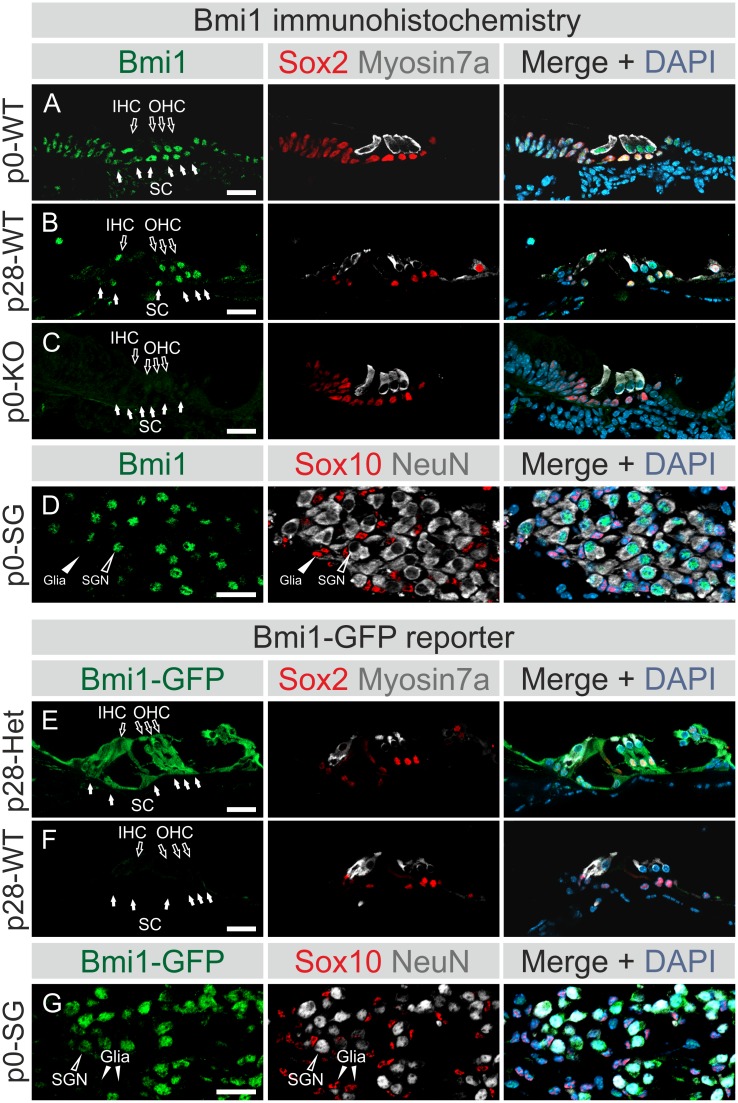
Bmi1 expression in the cochlear sensory epithelium.(A, B, and D) Immunohistochemical staining was performed using an anti-Bmi1 antibody on wildtype mice (Bmi1WT/WT, referred to as WT). (E and G) Alternatively, immunolabeling was performed using an anti-GFP antibody on Bmi1-GFP heterozygous mice (Bmi1GFP/WT, referred to as Het). OC sections (A-C, E and F) were co-stained for Sox2 (red) and Myosin7a (white) as markers of supporting cells and hair cells, respectively. Hair cells are marked by hollow white arrows, and supporting cells are indicated by solid white arrows. Spiral ganglion sections (D and G) were co-labeled with Sox10 (red) and NeuN (white) to serve as markers of glial and neuronal cells, respectively. Spiral ganglion neurons are labeled with hollow white arrowheads, and glial cells are marked with solid white arrowheads. (A) Bmi1 is expressed in the immature OC at p0. Both hair cells and supporting cells were labeled for Bmi1. (B) Bmi1 expression was detected in hair and supporting cells of the functionally mature OC at p28. (C) Cochleae of homozygous Bmi1-GFP mice (Bmi1GFP/GFP, referred to as KO) served as a negative control for Bmi1 immunohistochemistry. (D and G) Bmi1 expression co-localized with the neuronal marker NeuN in spiral ganglion neurons. Sox10-positive glial cells did not show Bmi1 expression. (E) Bmi1-GFP signal was observed in hair and supporting cells of the OC at p28. (F) Cochleae of WT mice served as a negative control for the Bmi1-GFP signal. Nuclei were labeled with DAPI in all sections. Solid white arrows indicate supporting cells, while hollow arrows point to inner and outer hair cells. IHC: inner hair cells, OHC: outer hair cells, SC: supporting cells, SG: spiral ganglion, SGN: spiral ganglion neurons. WT: wildtype, Het: heterozygous, KO: knockout. Scale: 20 μm.